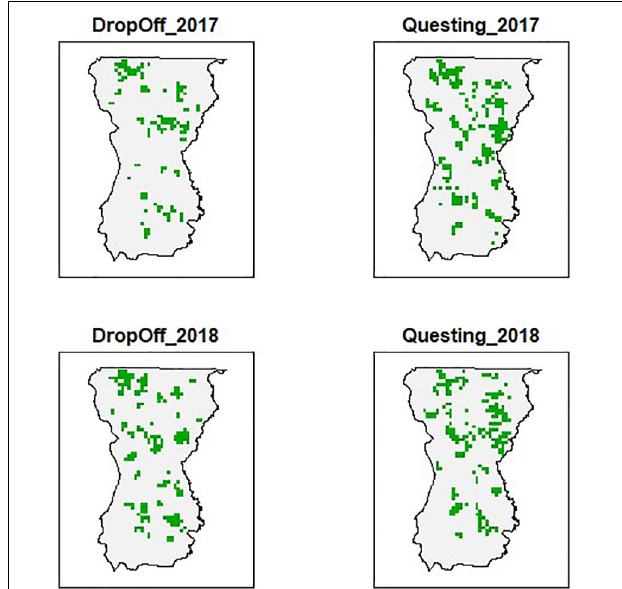
FIGURE 3 | An example (2017 and 2018) of detection locations of moose ( Alces alces; n = 74) across 1693 patches (1 km 2 ) in Wildlife Management Unit E during two important winter tick ( Dermacentor albipictus ) periods (questing and drop-off) in northeastern Vermont, United States. Patches that are green had at least one detection during the specified time, while white or blank patches had no detections of moose via GPS radio-collar